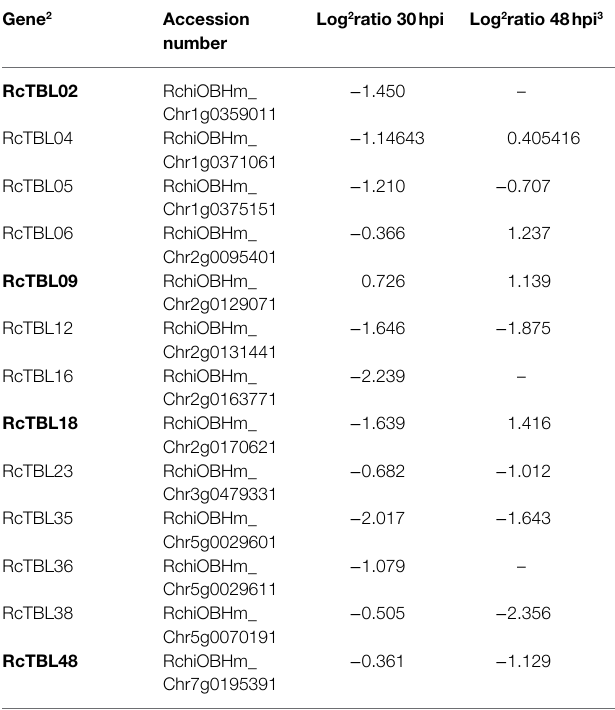
FIGURE 6 | Functional analysis of RcTBL16 . (A) Altered B. cinerea resistance upon silencing of RcTBL16 and unaltered B. cinerea resistance upon silenced RcTBL35 at 60 hpi post-inoculation. (B) Quantification of B. cinerea disease lesions on TRV-RcTBL16 , TRV-RcTBL35, and TRV-GFP - inoculated rose petal discs. The graph shows the lesion size from one replicate out of four ( n ≥ 48) with the standard deviation. (C) Quantification of RcTBL16 expression in TRV-RcTBL16 and TRV-GFP -inoculated petal discs. (D) Quantification of RcTBL35 expression in TRV-RcTBL35 and TRV- GFP - inoculated petal discs. Statistical analyses were performed using Student’s t test; * p < 0.01, * p < 0.05.